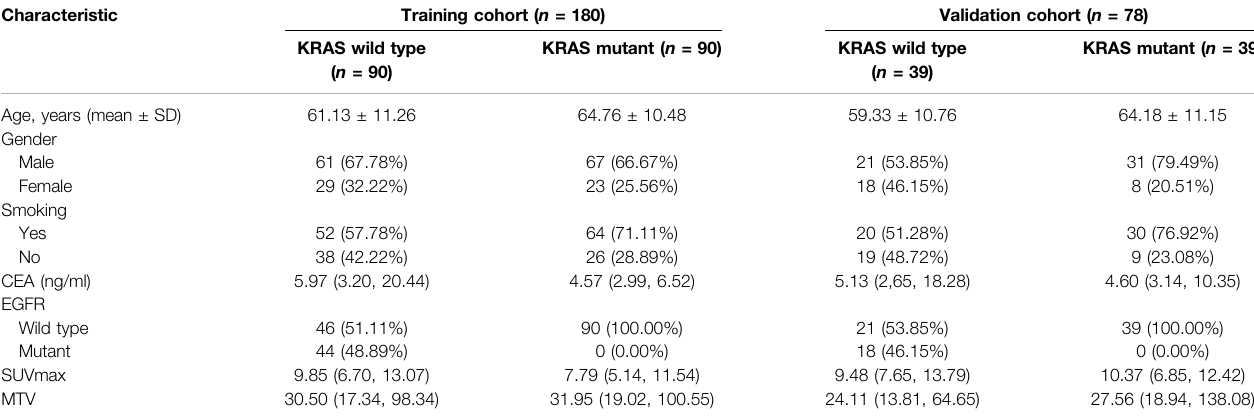
TABLE 1 | Characteristics of patients in predicting KRAS mutations.